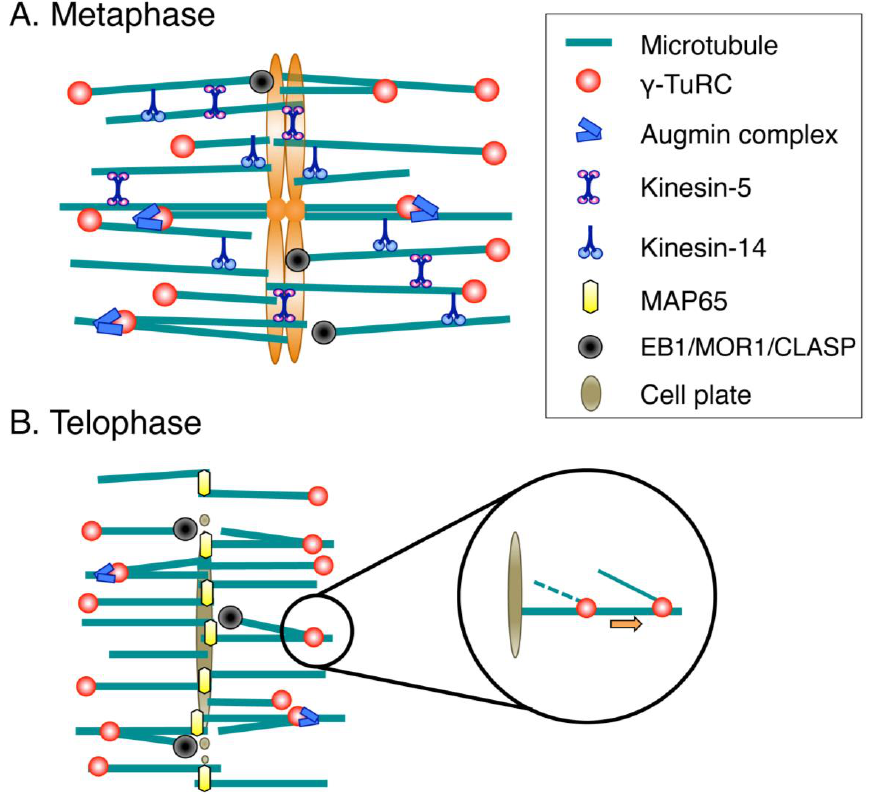
Figure 2. Molecular factors for spindle/phragmoplast assembly. ( A ) During prometaphase and metaphase, MTs are nucleated mainly by the γ-tubulin ring complex (γ-TuRC) and its recruitment/activation factor, the augmin complex. Multiple cross-linking proteins, including kinesin-5 and kinesin-14, shape the spindle. Spindle length is regulated by conserved MT plus-end-regulating proteins (EB1/MOR1/CLASP); ( B ) The MT-based arrays assembled after sister chromatid separation are called phragmoplasts. The central factors for MT generation in the phragmoplast are γ-TuRC and augmin, whereas MAP65 is an essential MT cross-linker that ensures phragmoplast bipolarity. MT plus ends are regulated by the same set of proteins as those acting during metaphase. Newly nucleated MTs are transported poleward via an unknown molecular mechanism.